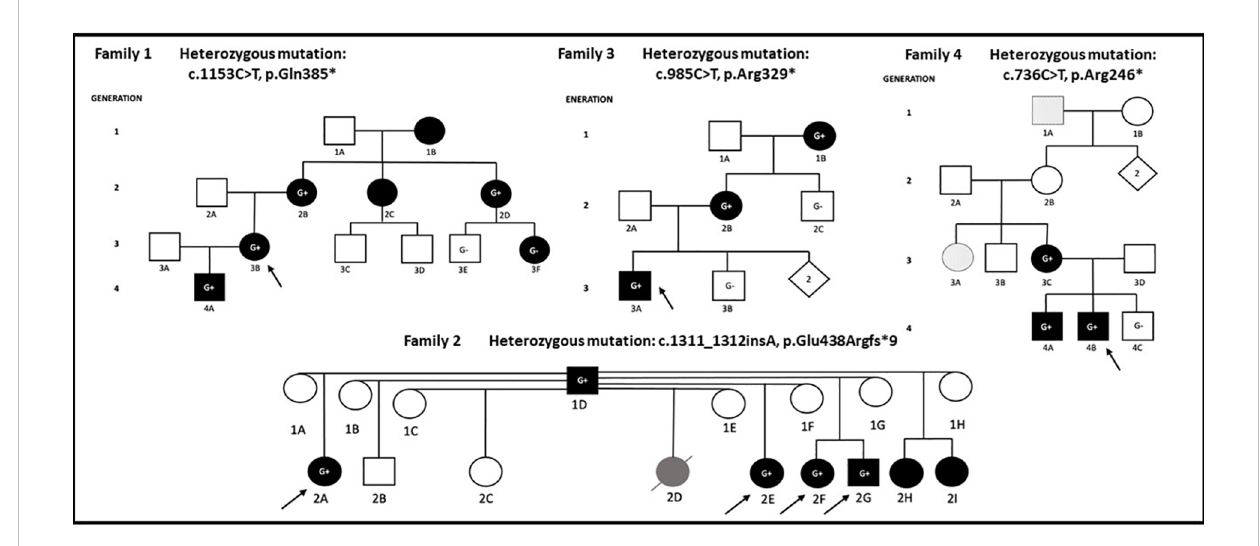
FIGURE 1 Proband in each family is denoted with arrow. Individuals shaded in black carry a combination of clinical features including mucocutaneous, musculoskeletal, gastrointestinal, neurological manifestations, infections, or fever. G+ denotes individual carrying pathogenic/likely pathogenic RELA variant, G- denotes wild type RELA, i ndividuals without ‘ G ’ were not sequenced. Patient (2D) in Family 2 died of lupus nephritis and is shaded in gray. Family 4: patients 1A and 3A presented with an isolated vesicular skin lesions and are shaded in